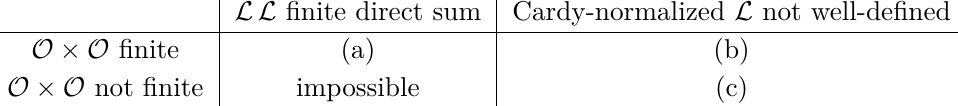
Table 1 . For a local operator O that is holomorphically-defect-factorized through a topological defect line L , the logical possibilities regarding the finiteness of highest-weight operators (with respect to the maximally extended chiral algebra) in the O × O OPE and whether a Cardy-normalized L is well-defined, such that the fusion L L gives a direct